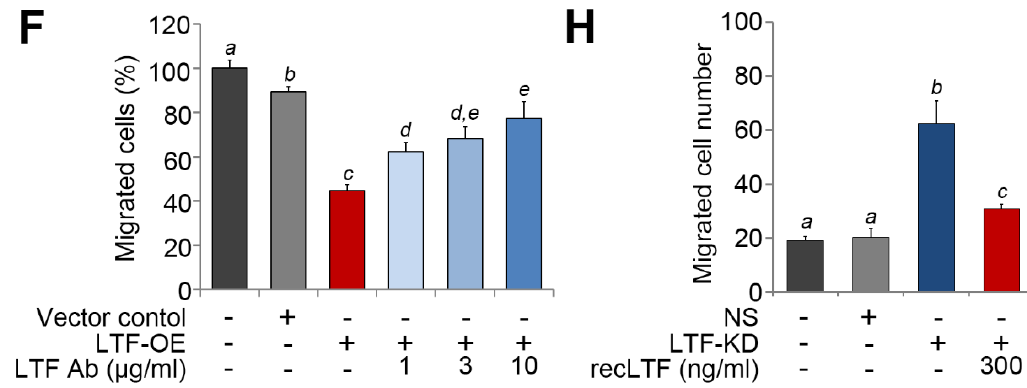
Figure 5. LTF inhibits the metastatic potential of ccRCC cells. ( A and B ) Giemsa staining (A) and histogram representing data from three independent experiments (B) analyzing migrated cells in the 3-h Transwell assay for ACHN cells pretreated with recombinant LTF (recLTF) protein at the indicated concentrations for 24 h. ( C ) Hematoxylin/eosin staining of lung tissues derived from mice post-transplantation with ACHN cells for 4 weeks without (vehicle, PBS) or with the administration of recLTF at 0.1 mg/kg twice a week. The red regions indicate the colonies of ACHN cells. Scale bars in the upper and lower pictures denote 3 and 0.2 mm, respectively. ( D ) Boxplot for the lung tumor colonies (>0.2 mm in diameter) counted from tumor-bearing mice ( n = 5) as shown in C. Nonparametric Mann–Whitney U test was used to estimate statistical significance. ( E and F ) Giemsa staining (E) and histogram representing data from three independent experiments (F) analyzing migrated cells after a 2-h Transwell assay in parental and vector control ACHN cells and LTF-OE ACHN cells pretreated without or with LTF antibody (Ab) at the designated concentrations for 24 h. ( G and H ) Giemsa staining (G) and histogram representing data from three independent experiments (H) analyzing migrated cells after a 3-h Transwell assay in parental and vector control A498 cells and LTF-silencing (LTF knockdown, LTF-KD) A498 cells pretreated without or with recLTF protein at 300 ng/mL for 24 h. The different letters in each column of F and H indicate statistical significance at p < 0.05 as determined by the Friedman test.